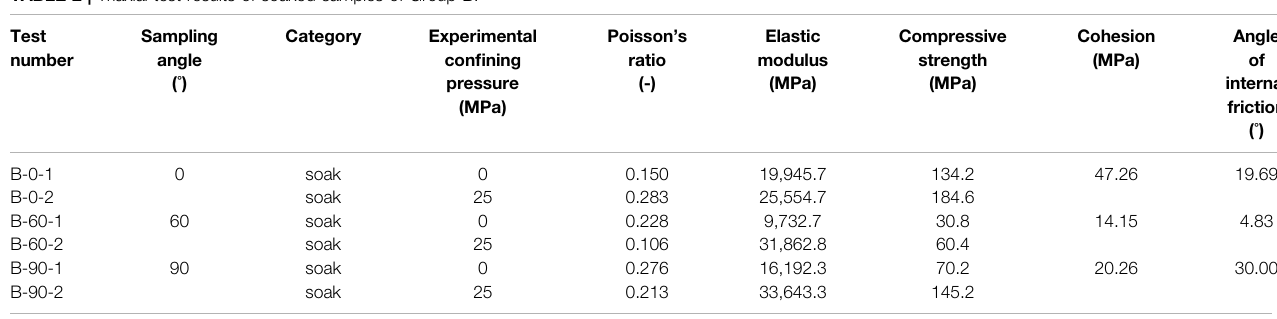
TABLE 2 | Triaxial test results of soaked samples of Group B.